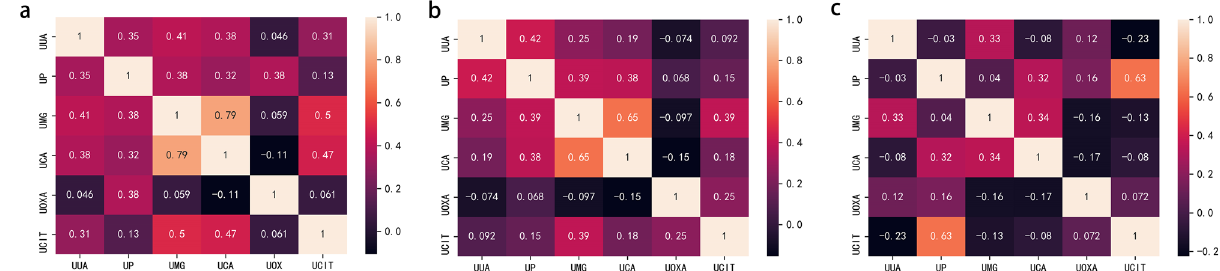
Figure 1. Association between stone components and urine chemicals were conducted in the single calcium oxalate group ( a ), mixed calcium oxalate group ( b ) and other stone group ( c ), respectively. P values were shown in the chart. The figure was performed using Python software version 3.8 (https:// www. python.